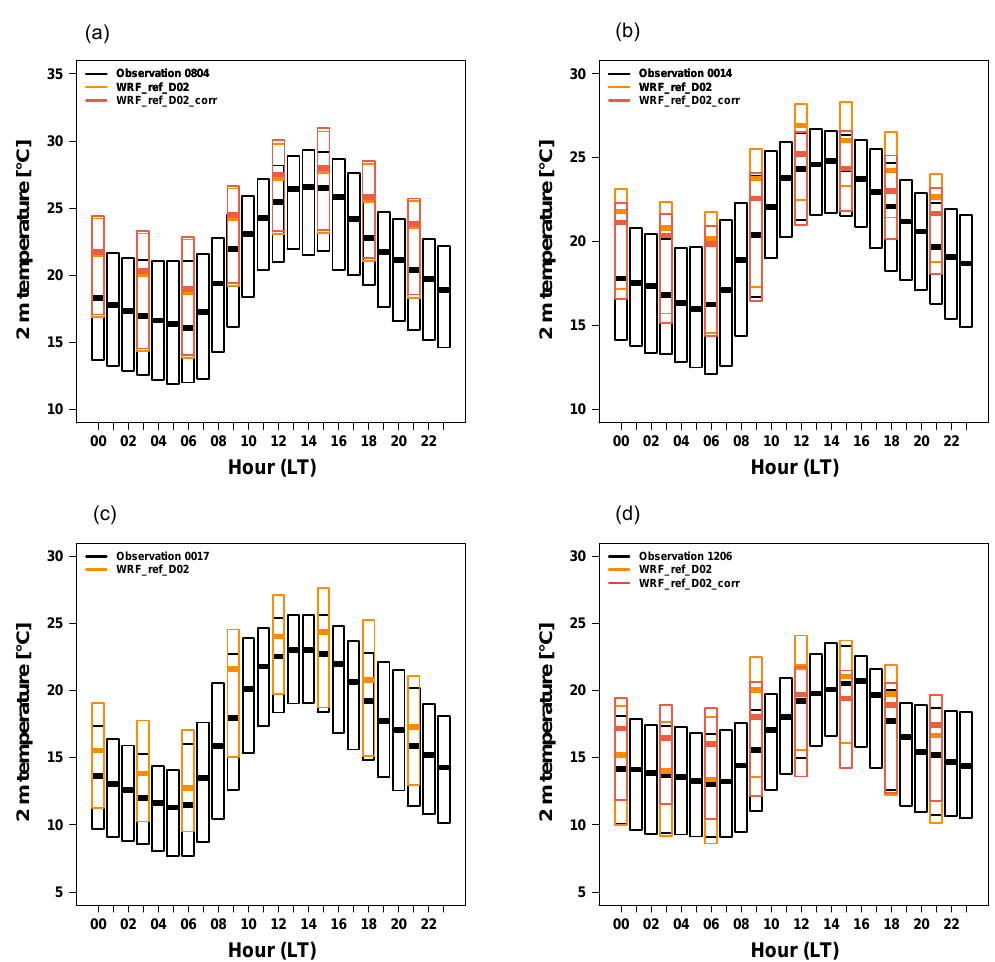
Figure 6. Diurnal cycle of the measured, simulated (WRF_ref_D02) and simulated but height-corrected (WRF_ref_D02_corr) 2m tempera- ture ( ◦ C) for the period of January–June 2013 as a boxplot (showing the median, the upper and lower quantiles) at stations 0804 (a) , 0014 (b) , 0017 (c) and 1206 (d)